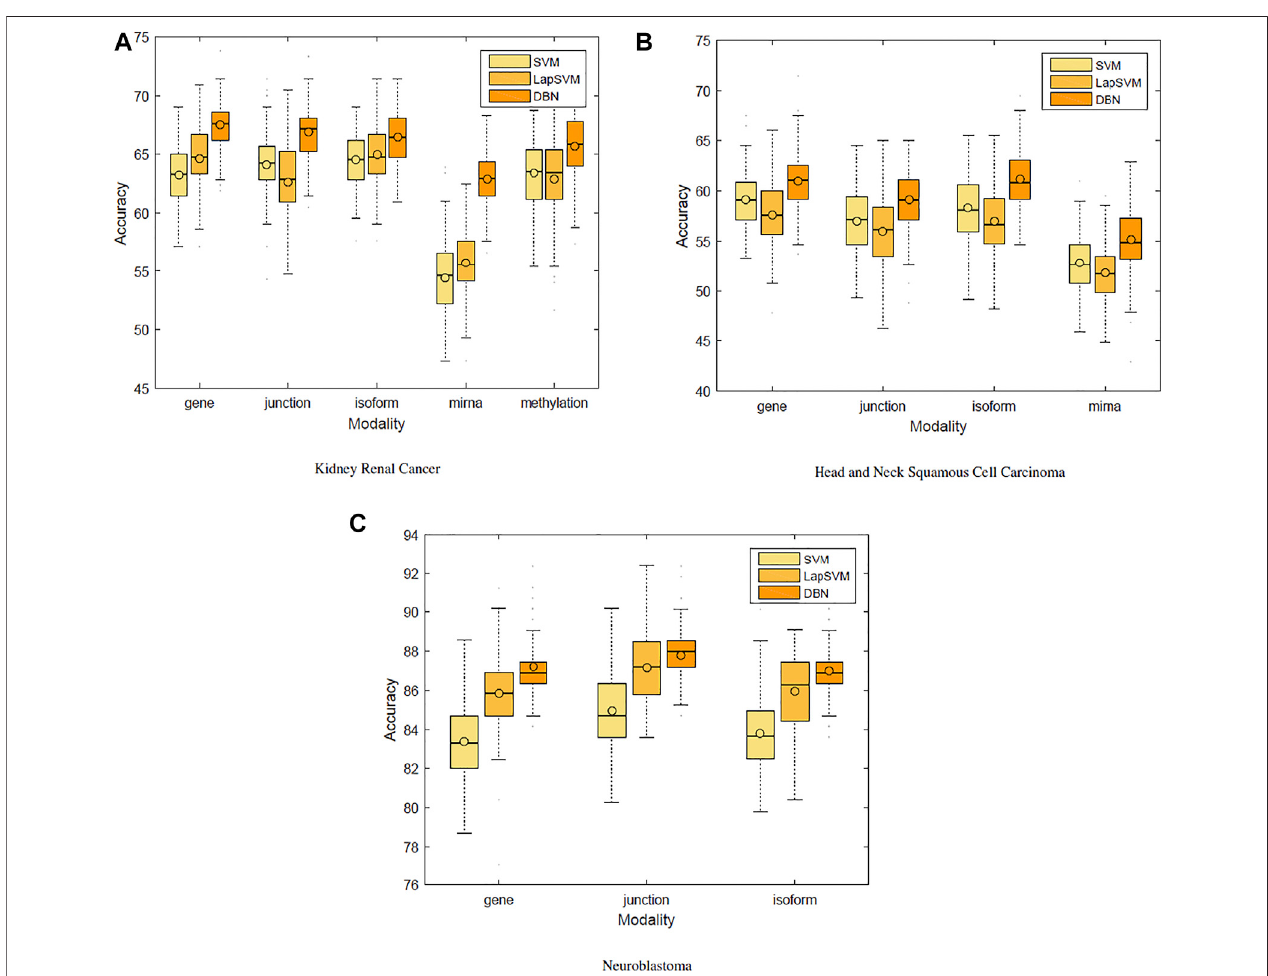
FIGURE 4 | Benchmarking support vector machines, Laplacian SVM, and deep belief